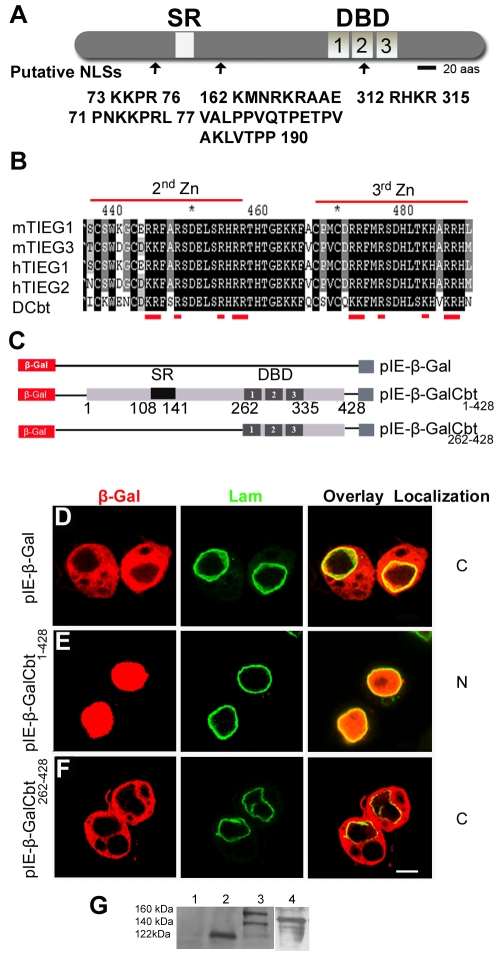
The Cabut zinc finger region is not essential for nuclear localization in S2 cells.(A) Schematic representation of the Drosophila Cbt protein, in which the locations of the Ser-rich (SR) region and the DBD are indicated. Sequences, coordinates and locations (arrows) of the predicted NLSs are also indicated. (B) Multiple alignment of the second and third zinc fingers of murine TIEG1 and TIEG3, human TIEG1 and TIEG2 and Drosophila Cbt. Red lines below the alignment indicate the amino acids included in the murine and human TIEG NLSs. (C) Schematic representation of the β-GalCbt fusion constructs used to transfect S2 cells. The locations of the SR region and the DBD are indicated by boxes. (D–F) Localization of β-Gal fusion proteins in S2 cells transiently transfected with the constructs shown in (C). Cells were stained with anti-β-Gal (red; first panel) and anti-Lam (green; second panel) to mark nuclear membranes. The overlay panel depicts double staining of cells with both antibodies, and the localization of the fusion proteins is shown in the fourth panel (C, cytoplasmic; N, nuclear). Wild-type β-Gal was located in the cytoplasm (D), but the β-GalCbt fusion protein translocated to the nucleus (E). However, the Cbt zinc finger region alone was not able to translocate β-Gal to the nucleus (F). Scale bar: 10 µm. (G) Western blot of protein extracts from S2 cells transfected with the constructs shown in (C) and stained with anti-β-Gal. (1) Non-transfected cells, (2) empty pIE-β-Gal vector (∼122 kDa), (3) pIE-β-GalCbt1–428 (∼160 kDa) and (4) pIE-β-GalCbt262–428 (∼140 kDa). Cells transfected with the pIE-β-GalCbt1–428 construct presented some degradation that did not affect the subcellular localization of the fusion protein.